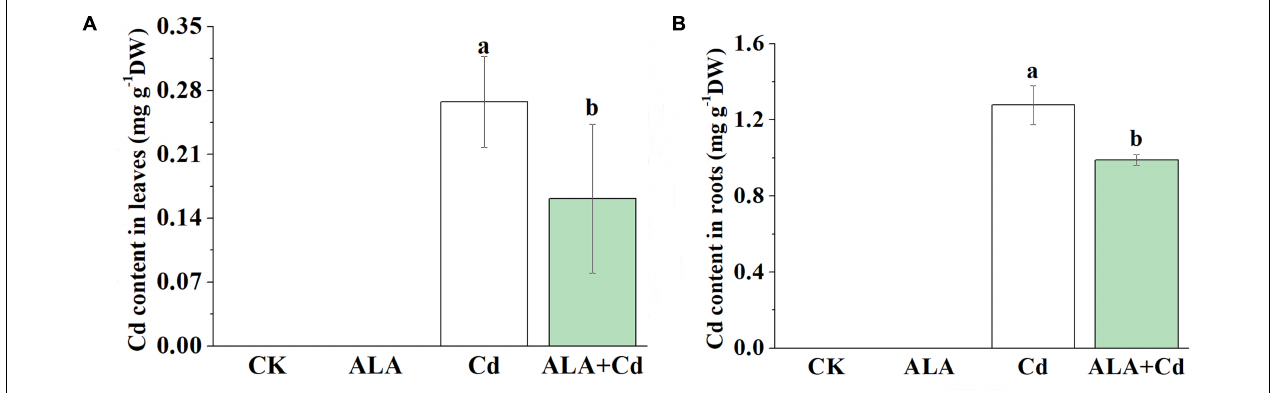
FIGURE 8 | Effects of ALA under Cd stress on content of Cd in leaves (A) and roots (B) . The seedlings were treated as in Figure 1 . The mean ± SE are shown ( n ≥ 3). Different letters indicate significant difference among the treatments ( P <